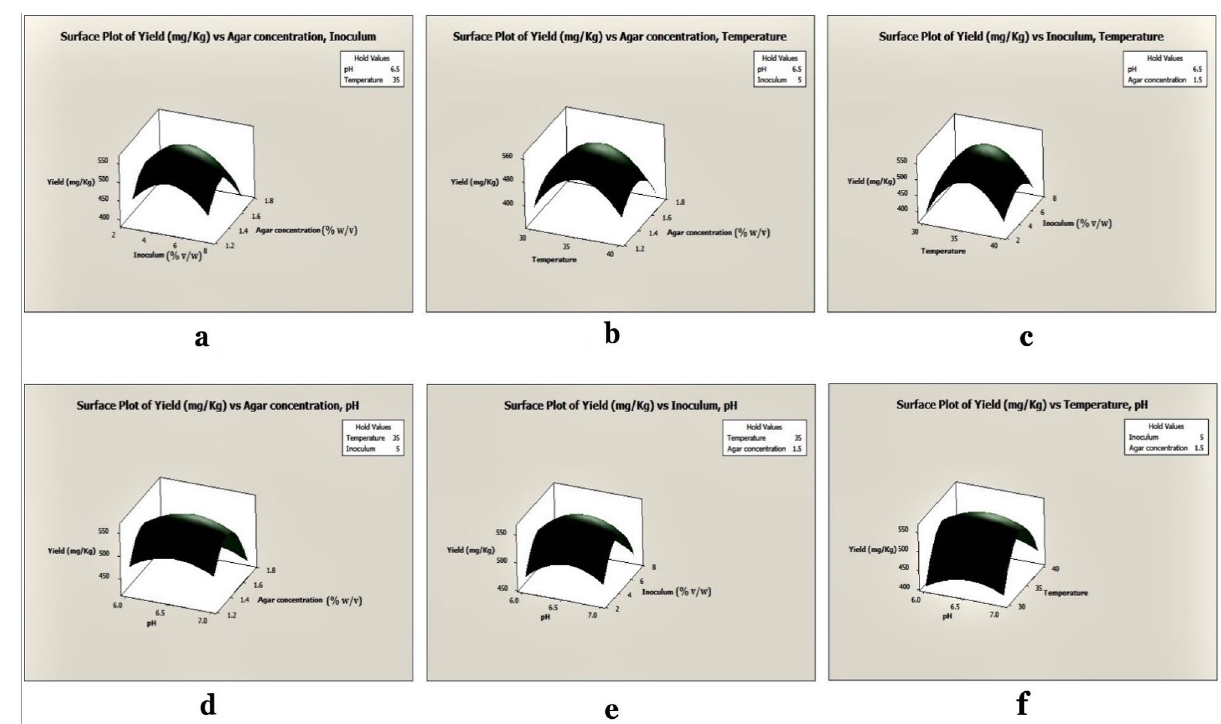
Figure 4. Surface plots of antimicrobial extract yield from